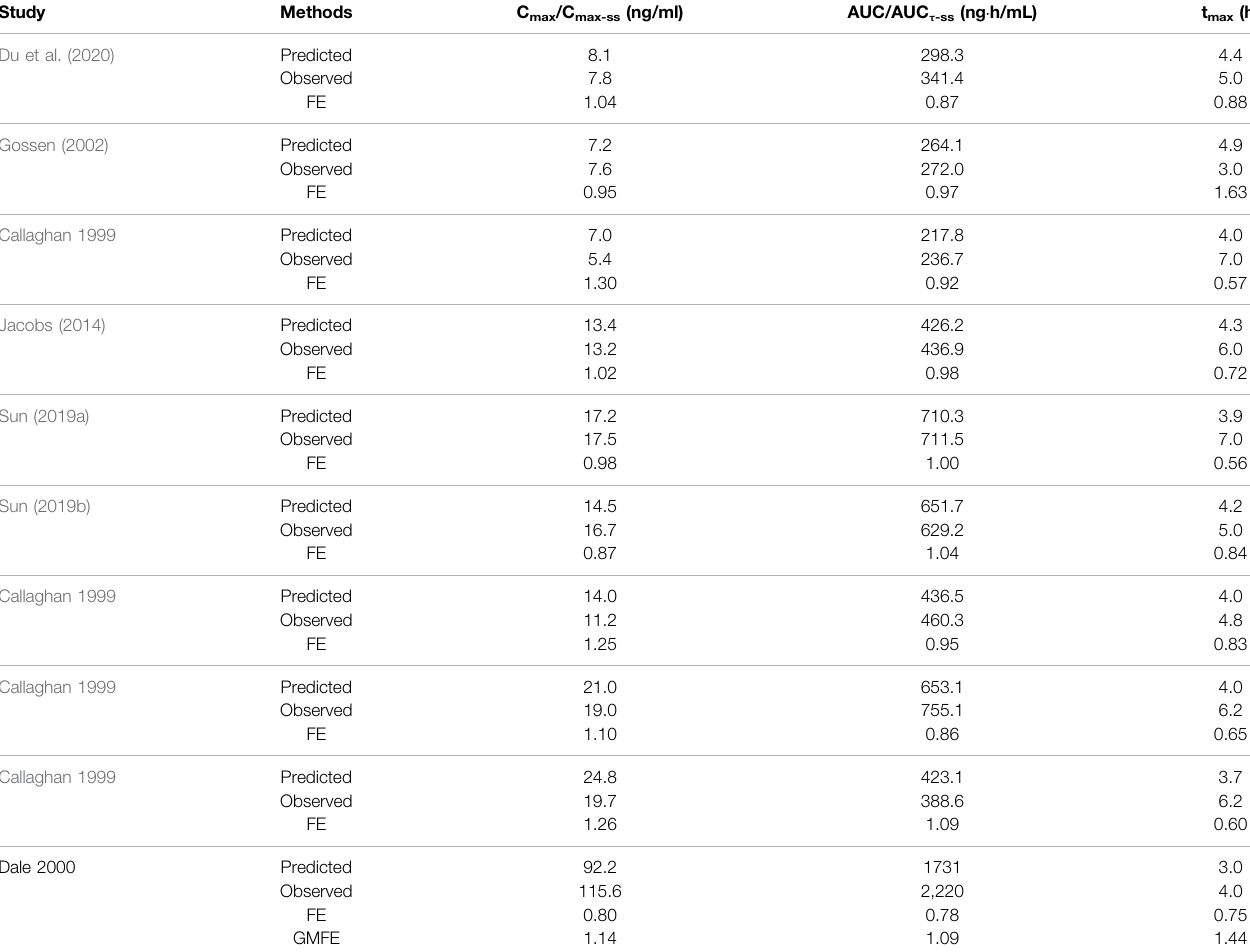
TABLE 4 | Predicted and observed pharmacokinetic parameters of olanzapine and geometric mean fold errors from model validation.